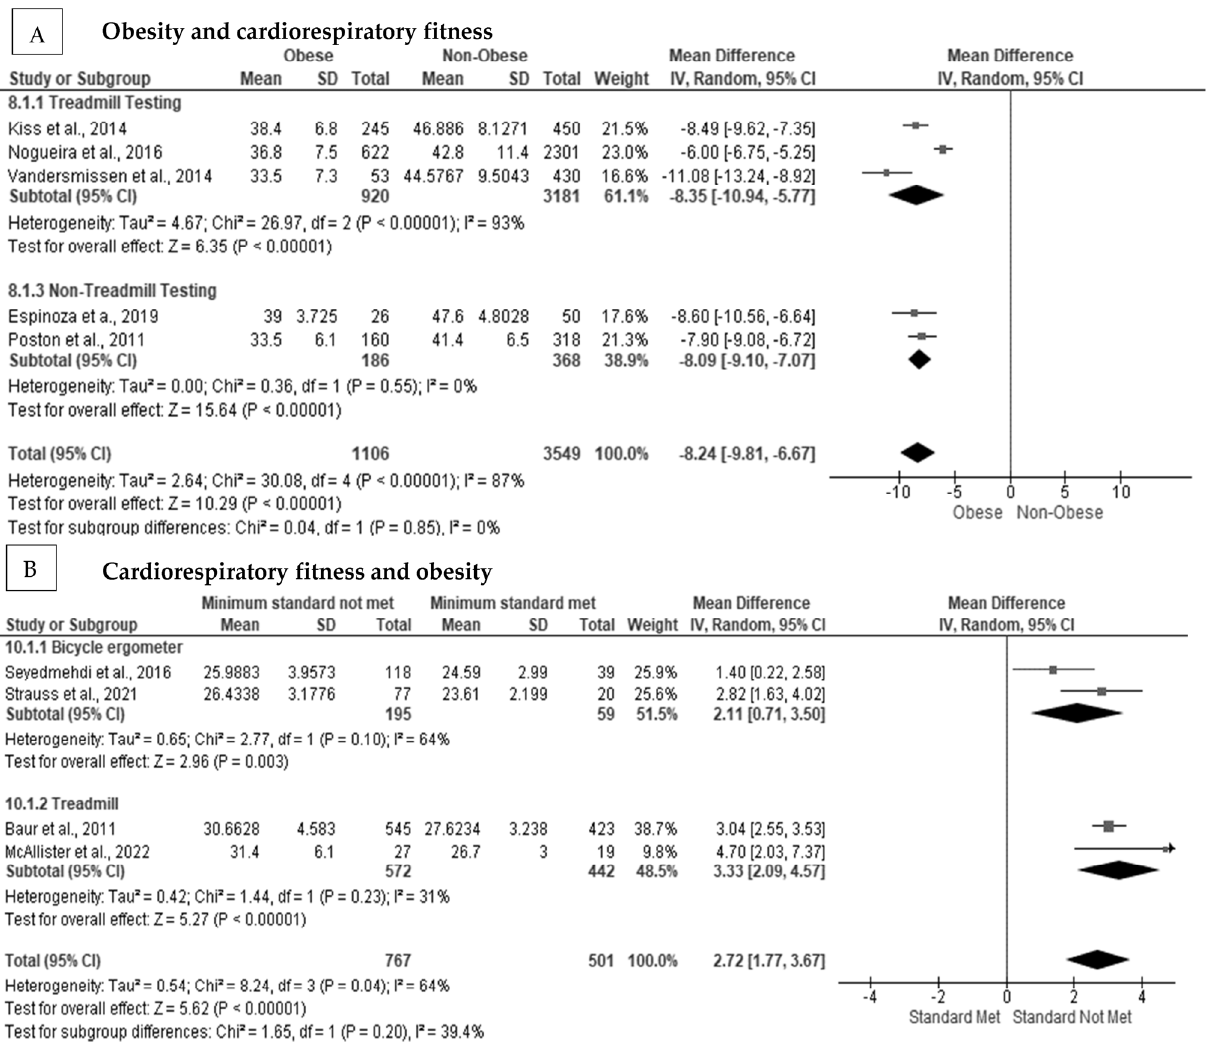
Figure 3. The association between obesity status on cardiorespiratory fitness in firefighters: ( A ) The association between obesity status and cardiorespiratory fitness with subgroup analysis [19,73,75,83,85]; ( B ) the association between cardiorespiratory fitness and BMI with subgroup analysis